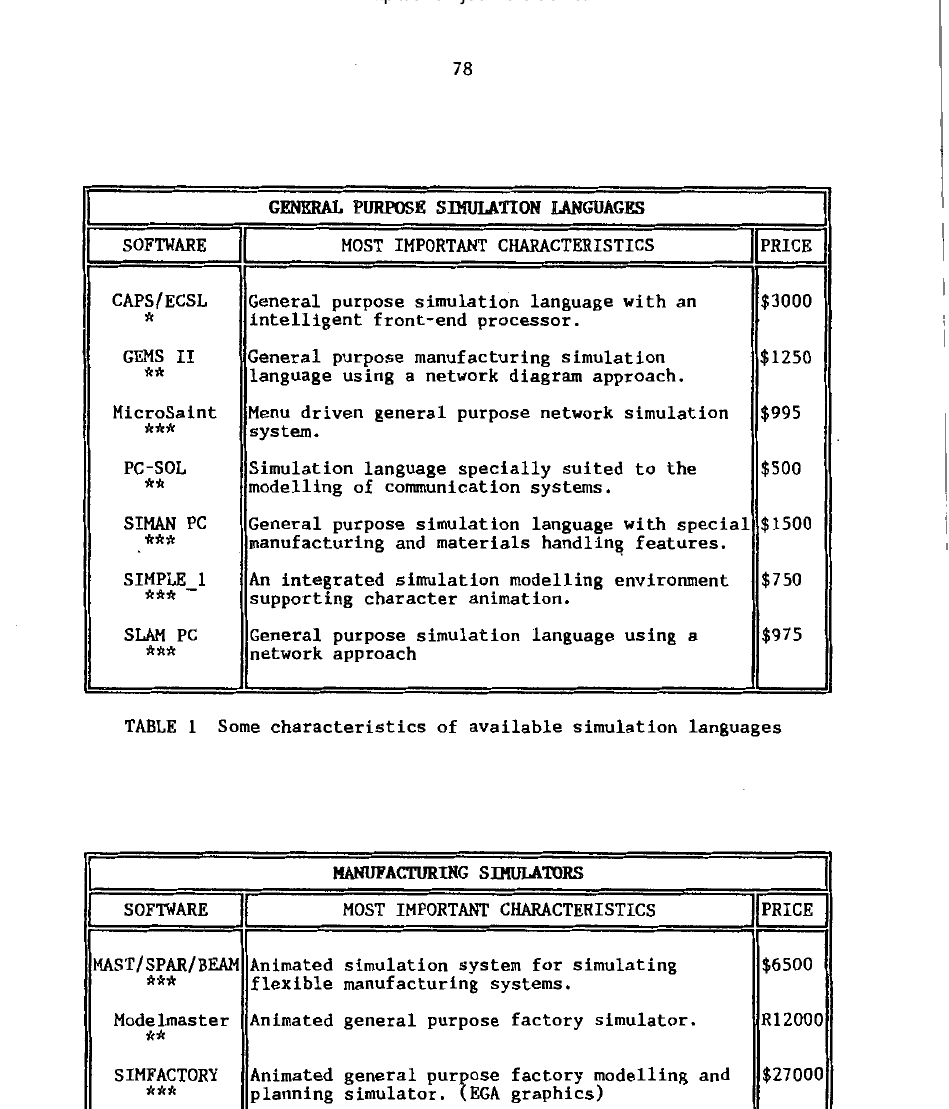
TABLE 2 Some characteristics of available manufacturing